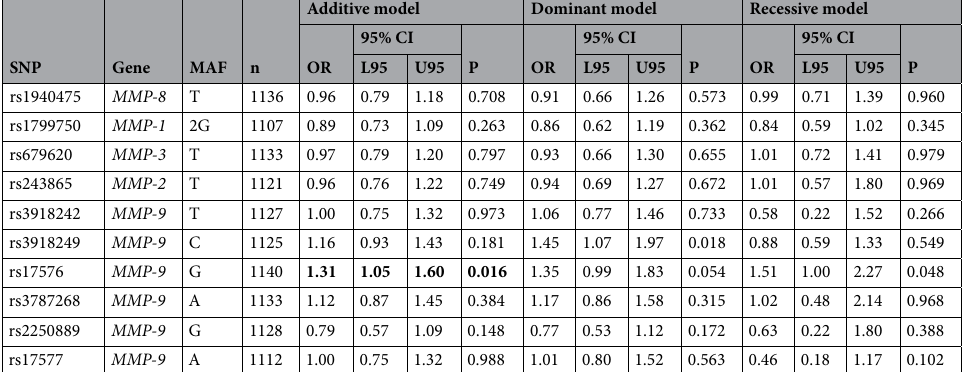
Supplementary Table S1 shows distributions of genotypes and alleles of the ten studied SNPs in the PUD patients and control groups. All analyzed SNPs were in the HWE (p > 0.005, p bonf > 0.05). The analysis yielded no significant associations for all the studied SNPs but one of the MMP-9 gene with PUD (Table 2). Specifically, the increased risk of PUD was associated with allele G of SNP rs17576 MMP-9 (additive model, the odds ratio adjusted for confounding factors OR adj = 1.31, p perm = 0.016, power—82.98%) (Table 2). Besides, two loci of the MMP-9 gene (rs3918249 and rs17576) were individually associated with H. pylori -positive PUD (Table 3). Allele C of SNP rs3918249 showed a significant association with the increased risk of H. pylori -positive PUD (dominant model, OR adj = 1.82, p perm = 0.002, power—96.43%). The increased risk of H. pylori -positive PUD was also associ- ated with a carriage of allele G of loci rs17576 according to the all three genetic models: additive (OR adj = 1.53, p perm = 0.001, power—98.14%), dominant (OR adj = 1.67, p perm = 0.013, power—90.21%), recessive (OR adj = 1.95, p perm = 0.007, power—94.75%).